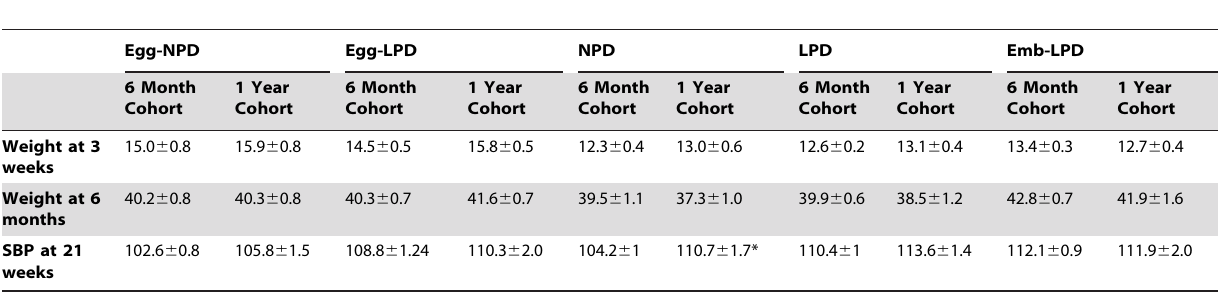
Table 4. Comparison of female offspring body weight and systolic blood pressure (SBP) measurements of mice analysed within the present study (1 Year Cohort) with the same treatment group from the larger cohort (6 Month Cohort) from which they were